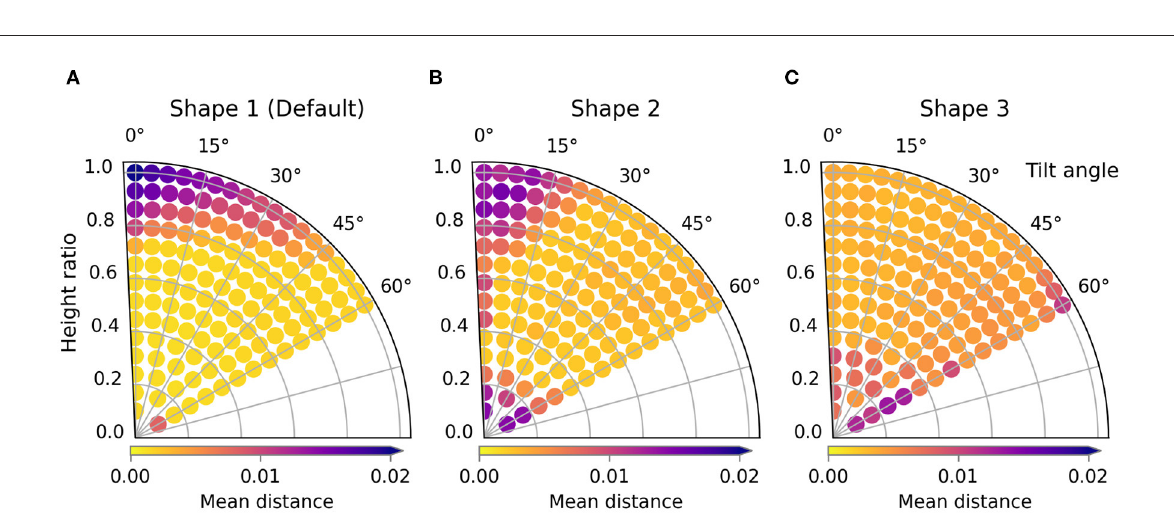
is five times higher than for the other sleeve folding